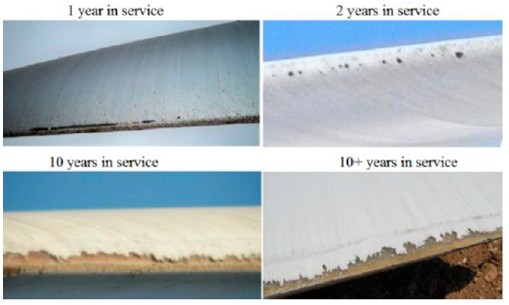
Figure 1. Examples of leading edge erosion across a range of years in service, from [1].